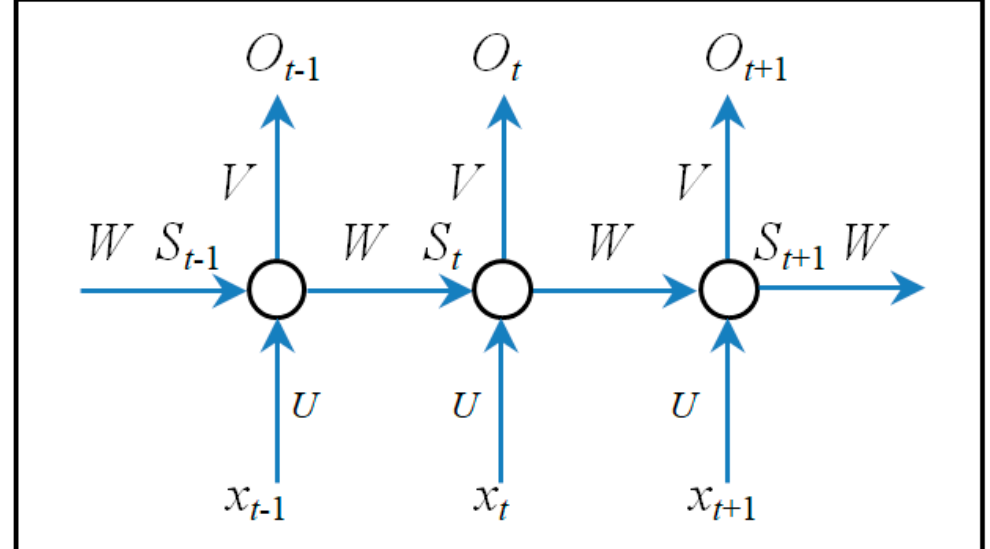
Figure 5. The architecture of recurrent neural networks [51].